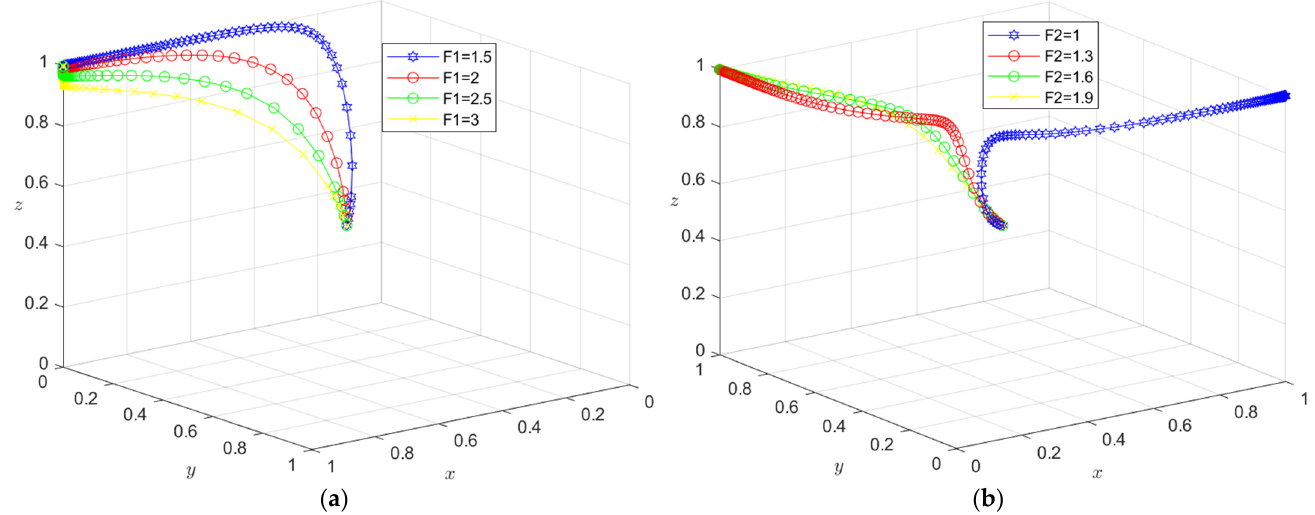
Figure 6. ( a ) Evolution path of the developer, general contractor, and government under different government punishments F 1 . ( b ) Evolution path of the developer, general contractor, and government under different government punishments F 2